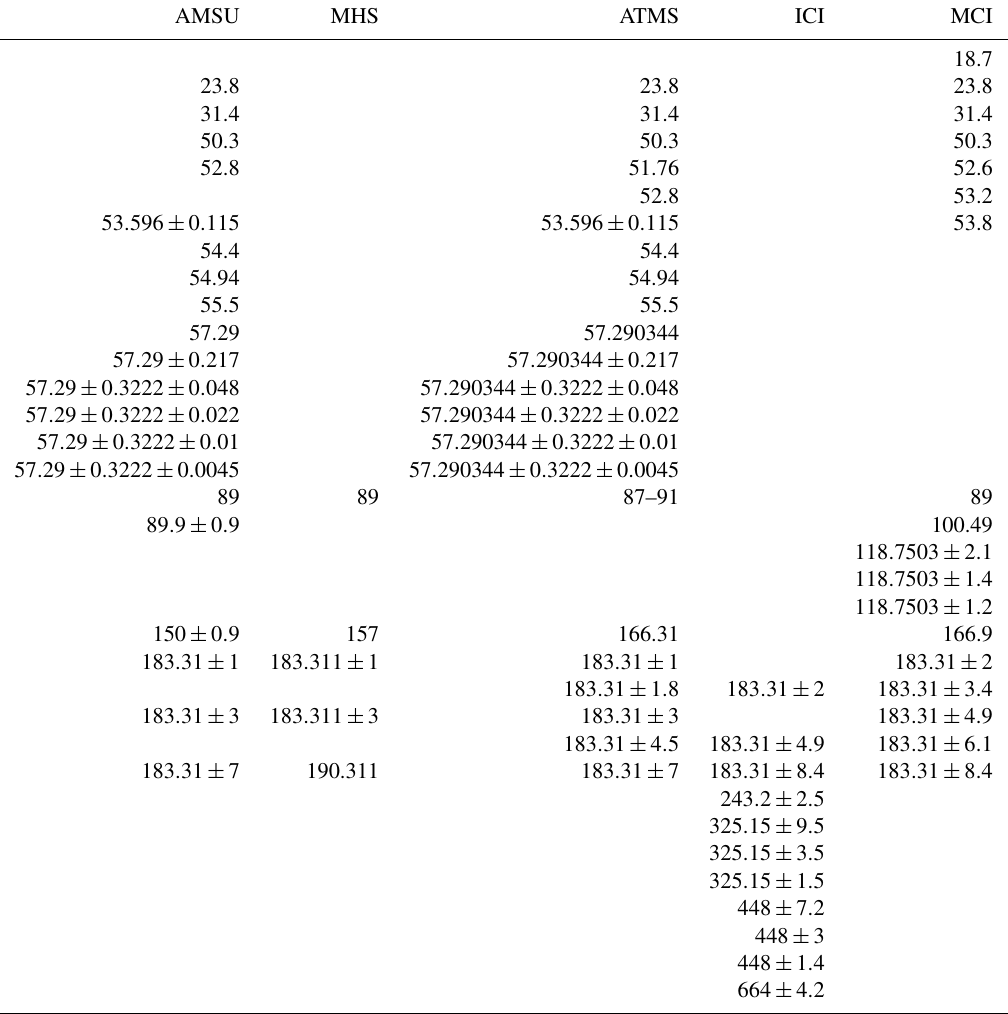
Table 3. Channel frequencies in GHz of different microwave instruments. The values were obtained from Goodrum et al. (2014), Weng et al. (2013), and Alberti et al. (2012).